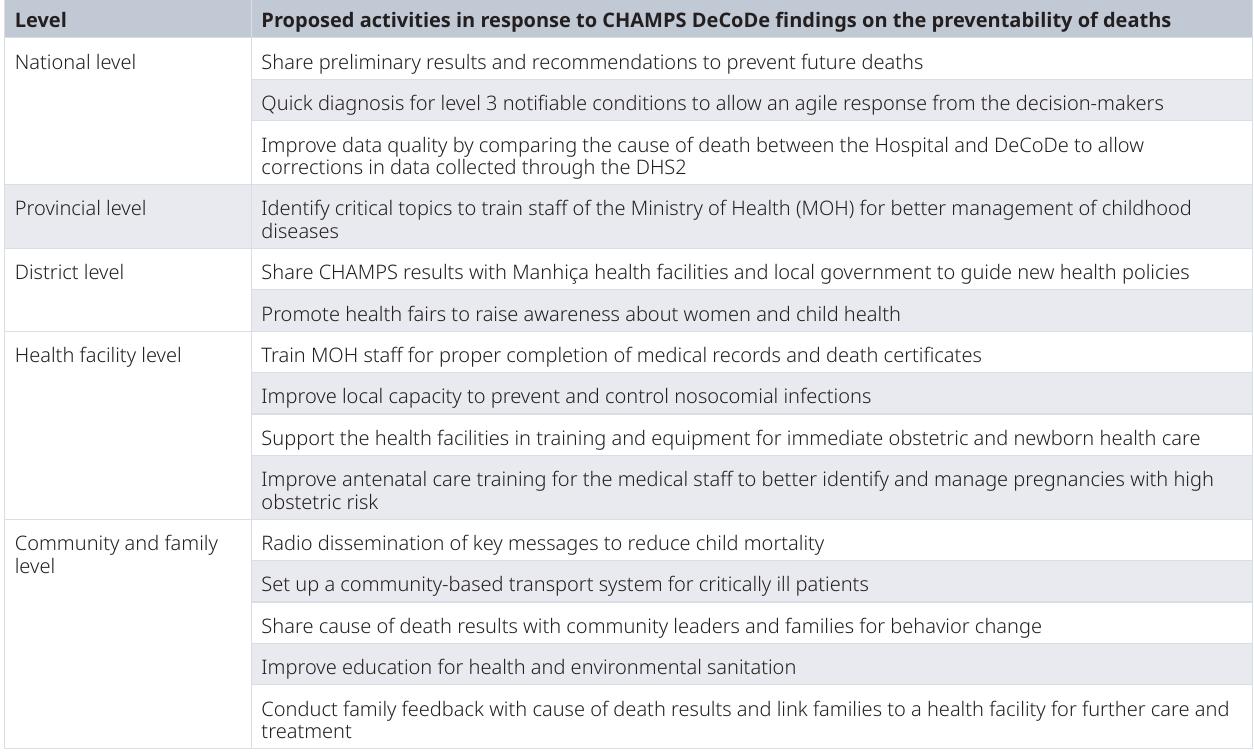
Table 2. CHAMPS selected actionable “hot issues” to reduce child mortality in the area at different levels of intervention.